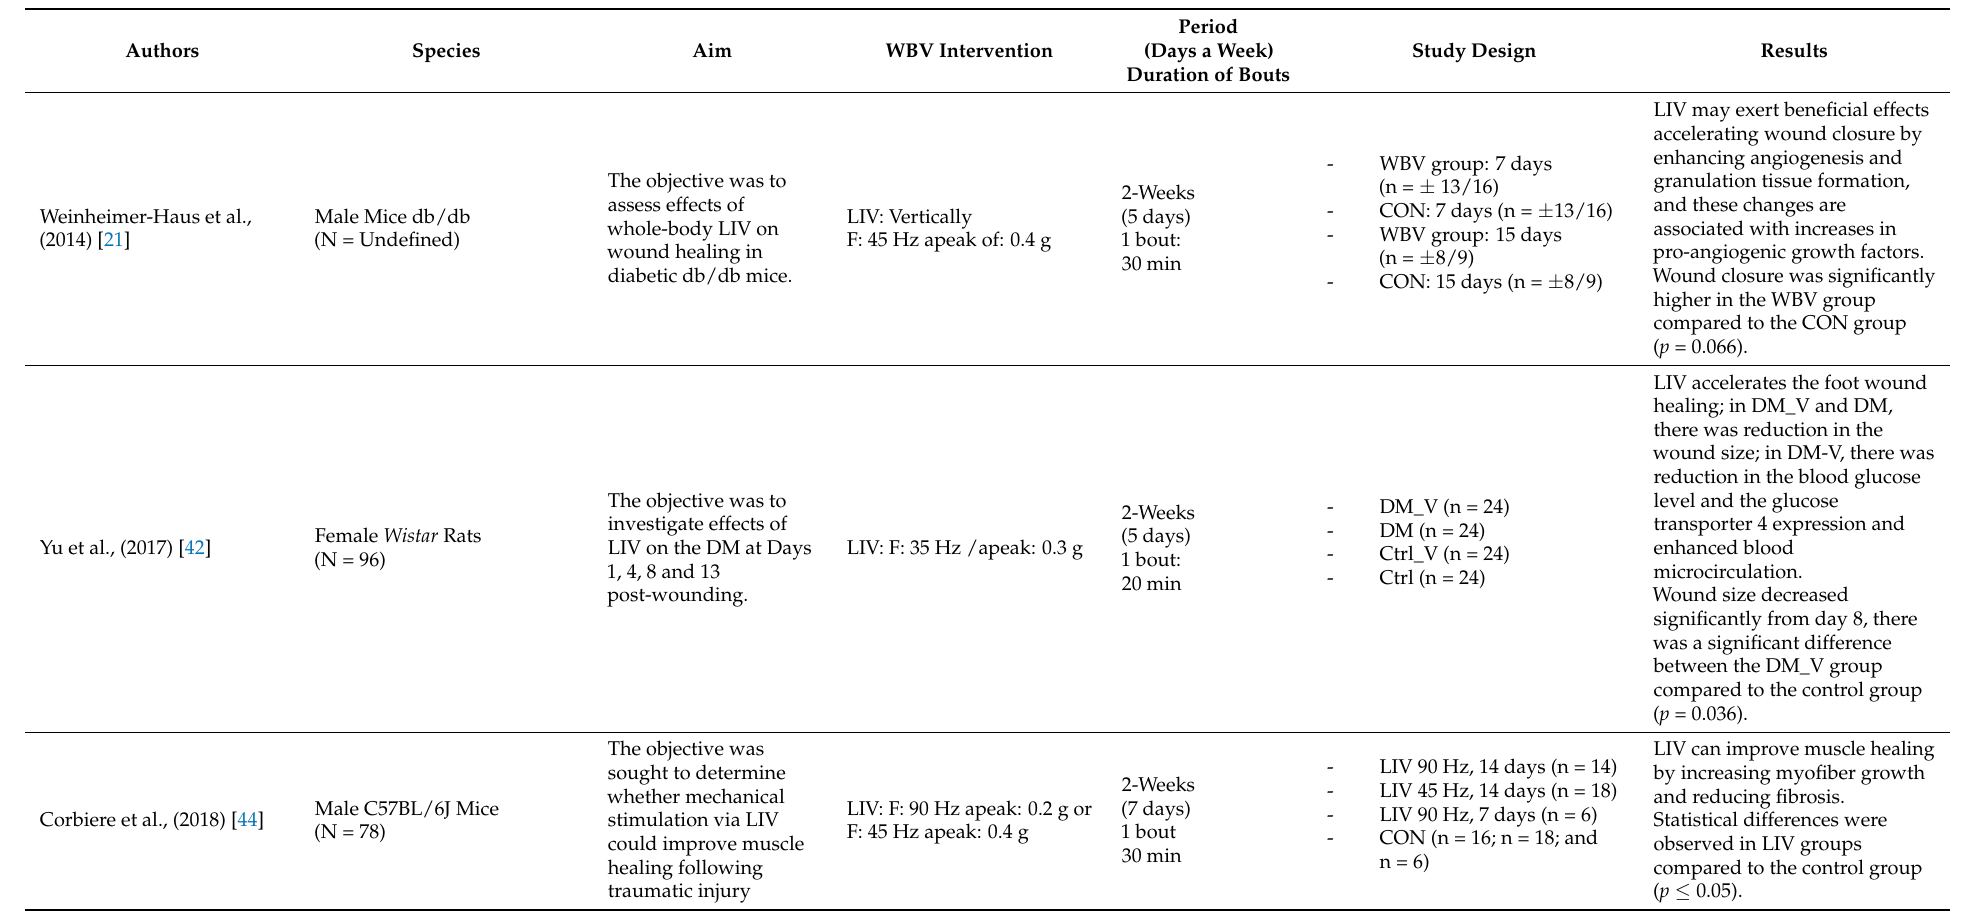
Table 1. Summary of in vivo experimental studies investigating the effects of WBV in wound